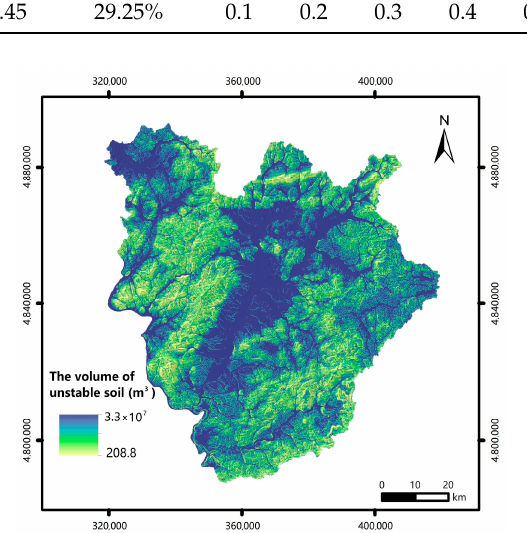
Table 3. Curve number (CN) values reflecting antecedent runoff condition III (ARC III).